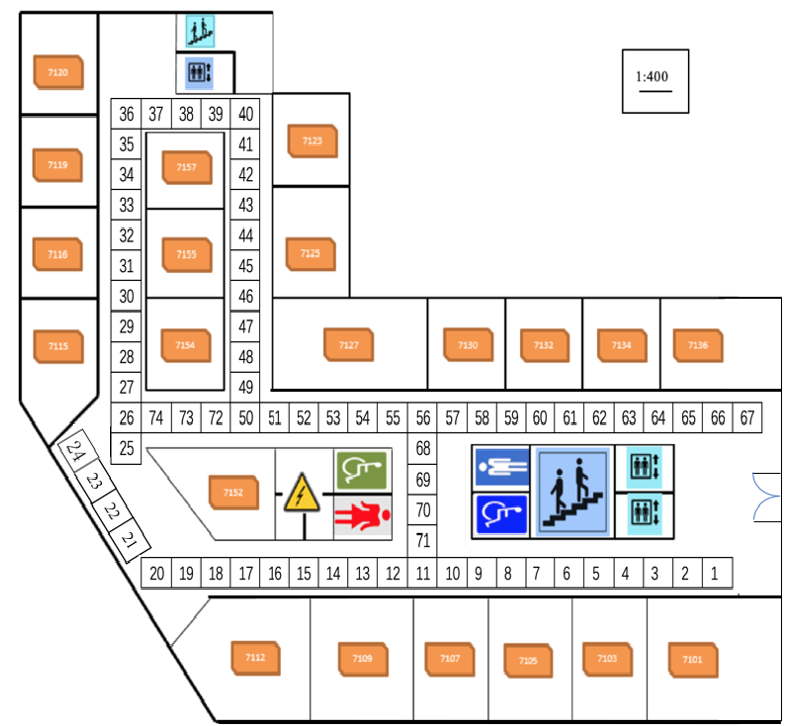
Figure 2. Environment setup for floor map with 74 reference points.